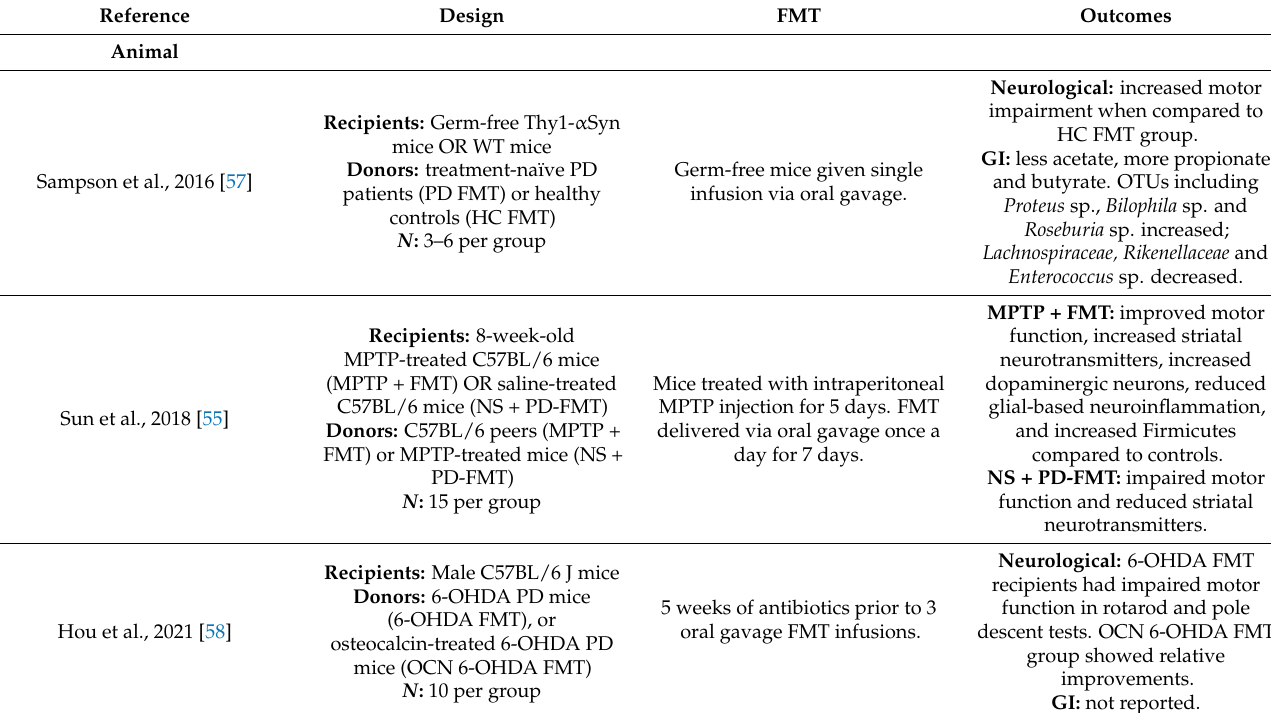
Table 2. PD research involving